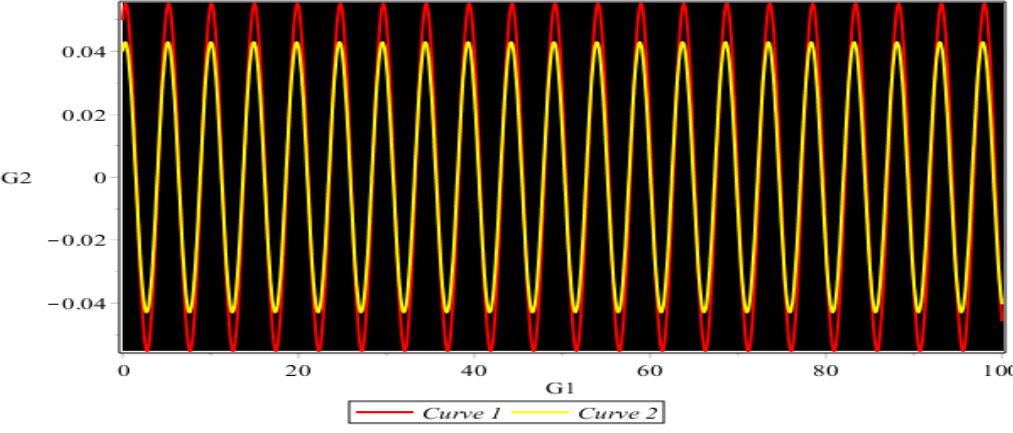
Figure 5. Sensitivity presentation for curve 1 at (0.05, 0.03) and curve 2 at (0.04, 0.02).